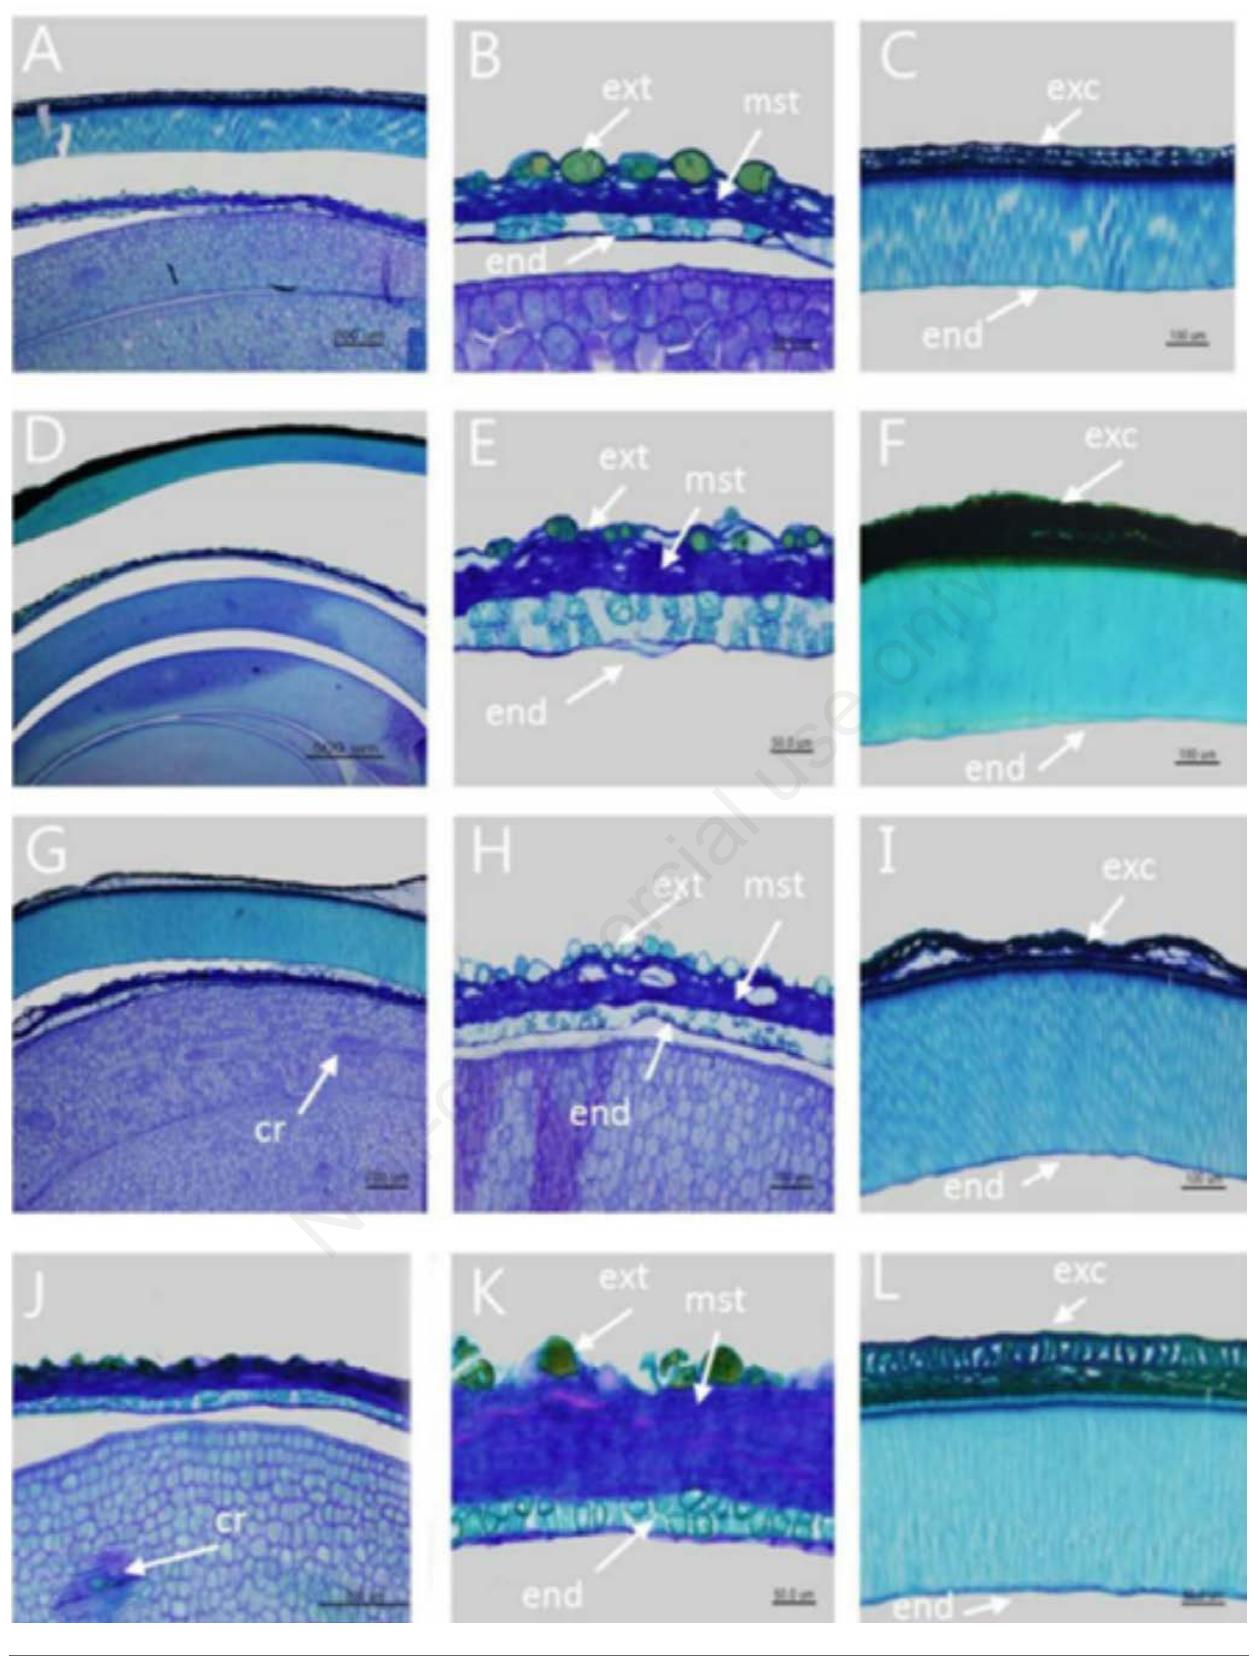
Figure 4. Seed anatomy of Calycanthaceae. A-C, Sinocalycanthus chinensis ; D-F, Calycanthus occidentalis ; G-I, Chimonanthus praecox ; J-L, Chimonanthus nitens . Abbreviation: end, endotesta; ext, exotesta; mst, mesotesta; exc; exocarp; enc, endocarp; cr,